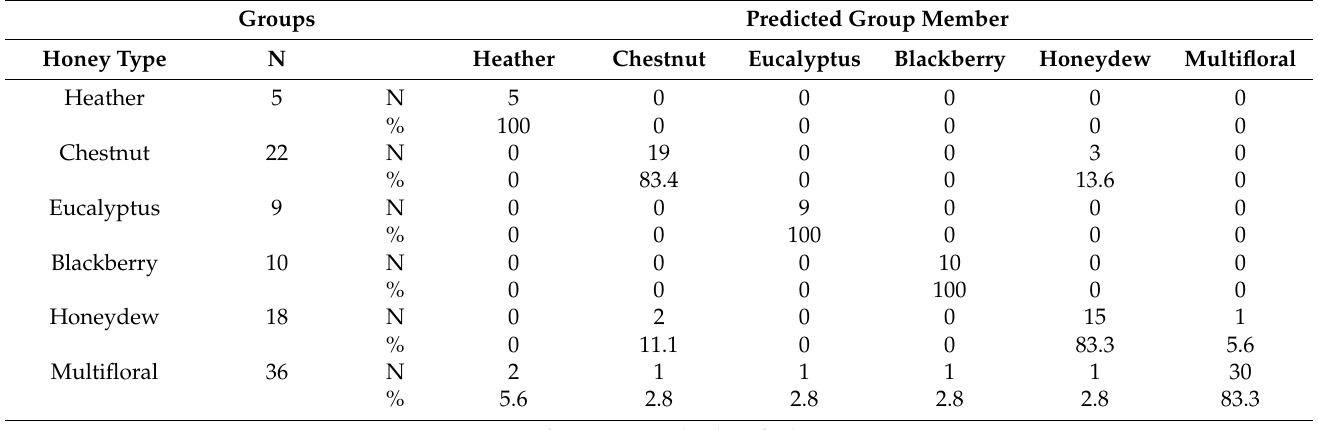
Table 6. Results of classification of honey samples considering the linear discriminant analysis.